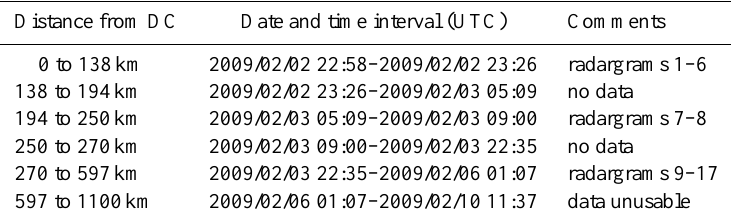
Table 1. Summary of the radar data from DC to the coast. Gaps in the data are due to technical problems encountered during the transect. The fact that data starting at 597km from DC is unusable was due to a deterioration of the antenna, as explained in the text. See Fig. 1 for explanation of the numbering of the profiles.